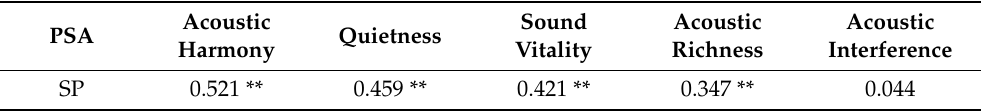
Table 7. Spearman correlation between soundscape preference (SP) and perceived soundscape attributes (PSA). Sound Acoustic Acoustic Acoustic Quietness PSA Vitality Richness Interference Harmony SP 0.521 ** 0.459 ** 0.421 ** 0.347 ** 0.044 ** p <